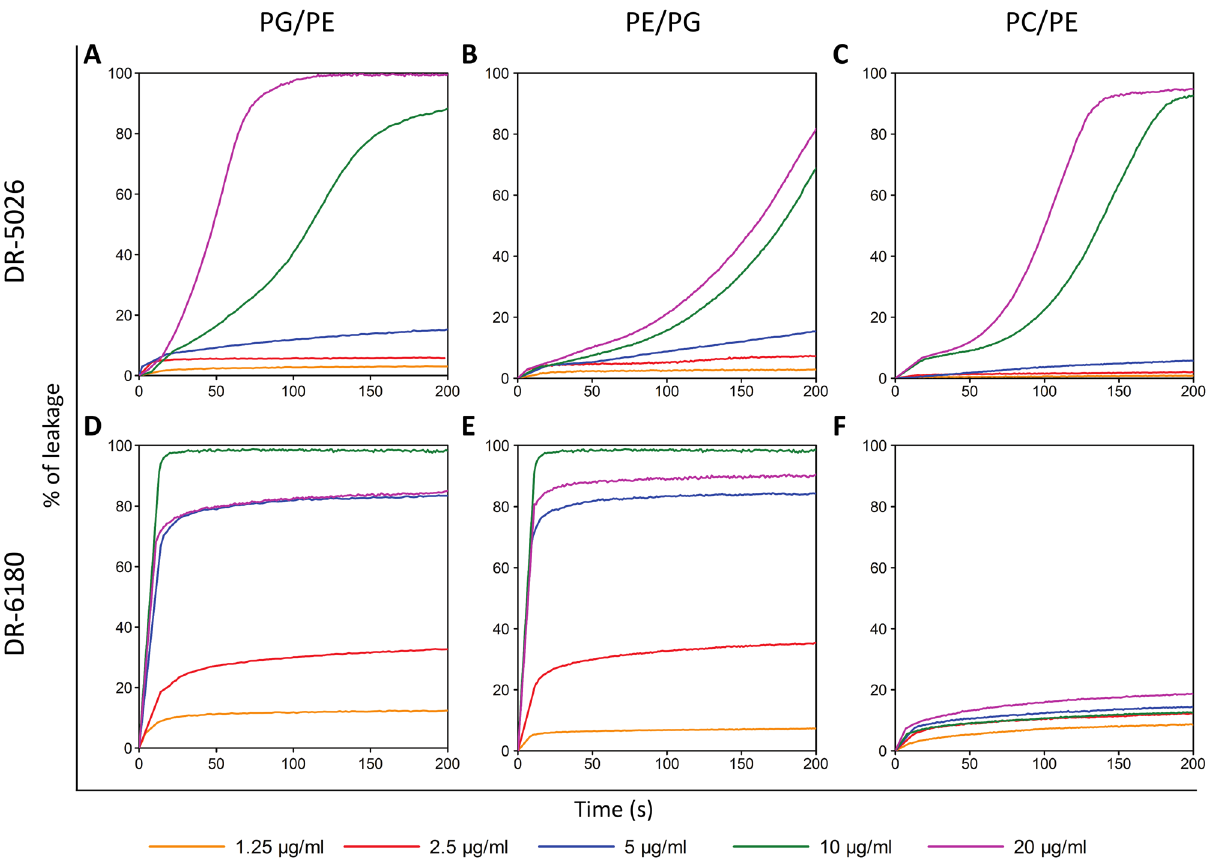
Figure 7. LPPO-induced leakage of carboxyfluorescein from liposomes. The curves show concentration dependence of LPPO I- (DR-5026, A – C ) and LPPO II- (DR-6180, D – F ) induced leakage from liposomes over time. The liposomes were composed of dioleyl-phospholipids in a 2:1 (w/w) ratio—PG/PE, PE/PG and PC/PE. The LPPO/phospholipid ratios were as follows: DR-5026—0.18/1, 0.36/1, 0.72/1, 1.43/1 and 2.86/1; DR-6180— 0.14/1, 0.29/1, 0.58/1, 1.15/1 and 2.30/1. 100% leakage was achieved using 0.1% Triton X-100. Representative kinetics from at least three independent liposome preparations are